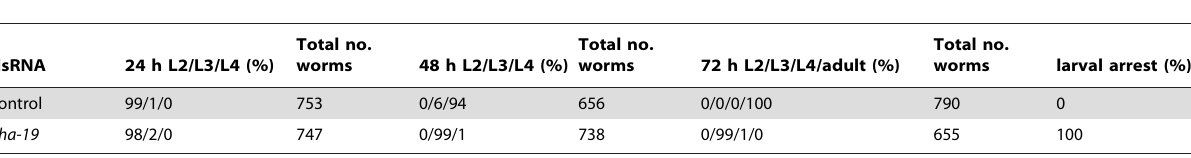
Table 1. C. elegans arrest as larvae when fed on vha-19 dsRNA from the first larval stage.